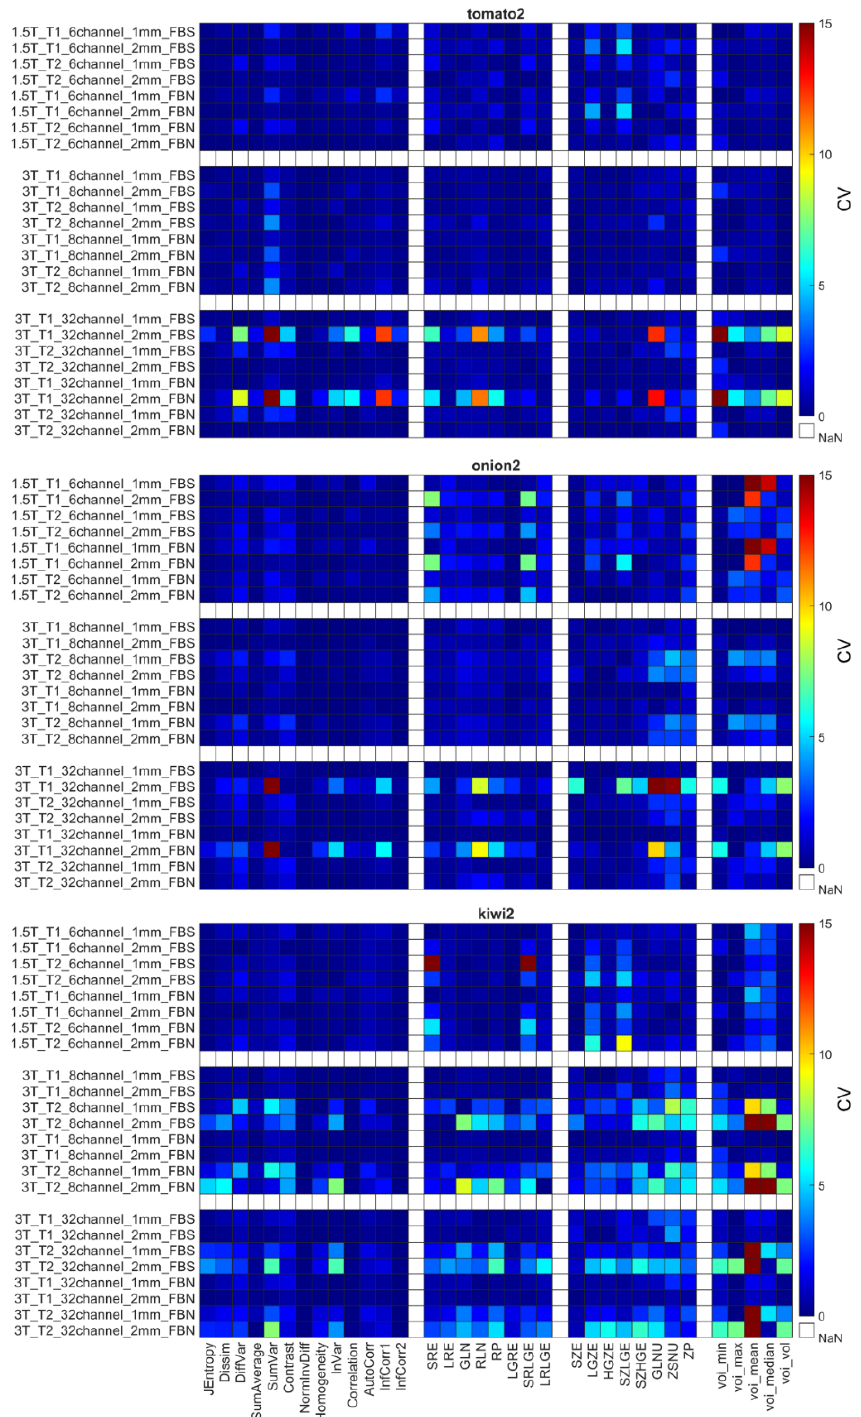
Figure 6. CV of radiomics data obtained for the second tomato, onion, and kiwi. Corresponding figures for all phantoms can be found in the Supplementary Figure S3. The CV is expressed in %.